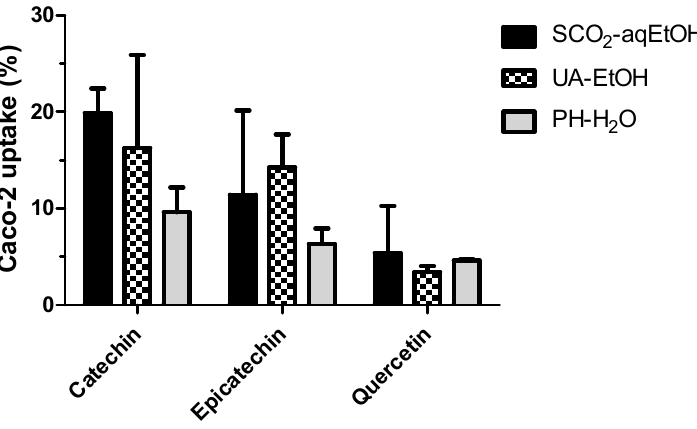
Figure 3. Cellular uptake of phenolics compounds from different black rosehip extracts.